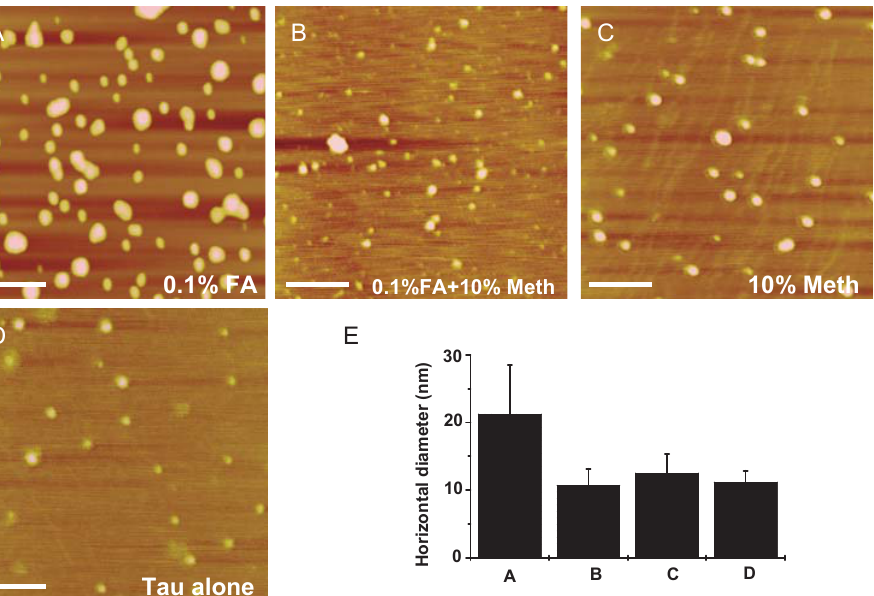
Figure 8. Effect of 10% methanol on neuronal tau aggregation. Conditions were referred to Figure 1, except that additional methanol was used to disturb the reaction of formaldehyde with neuronal tau. The images show neuronal tau incubated in phosphate buffer in the presence of 0.1% formaldehyde only ( A ); mixture of 10% methanol and 0.1% formaldehyde ( B ); 10% methanol only ( C ); and tau alone ( D ). The scale bars equal 100 nm. The corresponding horizontal diameters are summarized in E